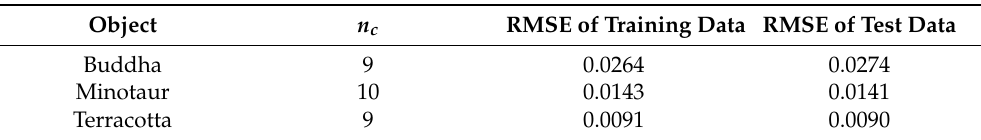
Table 2. RMS errors of the DEN for the training data and the test data in the BTF dataset. The number of basis BRDFs n c are also listed in the table.